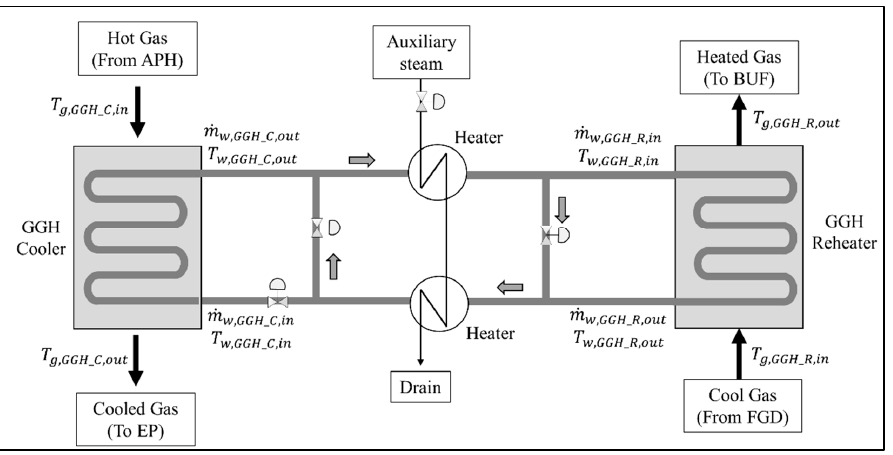
Figure 4. Schematic configuration for flue gas and water flow in a general gas–gas heater, cooler, and reheater.